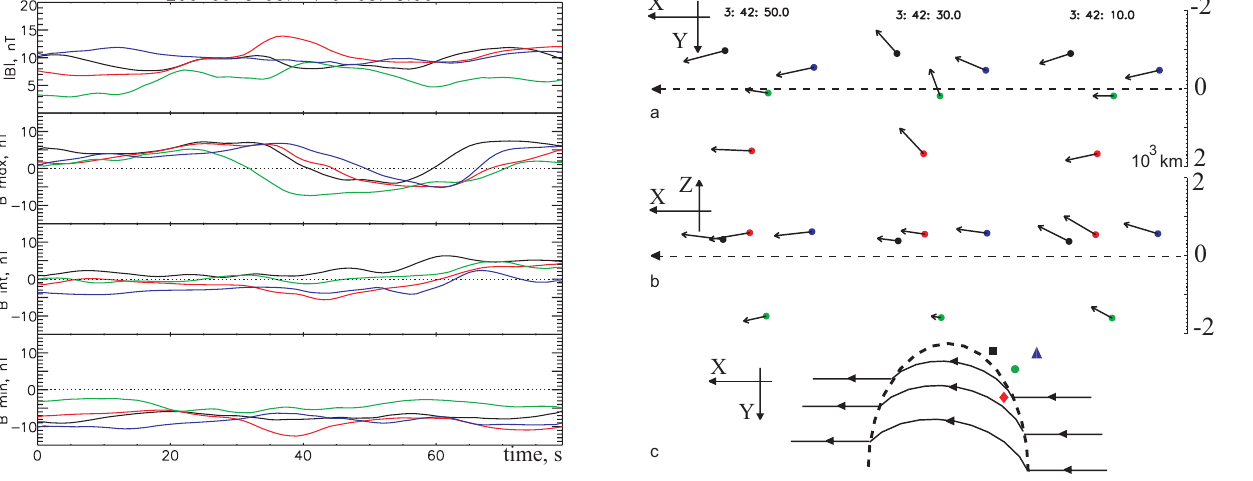
Fig. 7. Interval A 1: Projections of the magnetic field at the four s/c (black arrows) onto the XY (a) and XZ (b) GSM planes at three successive instances. The 3-D interpretation cartoon (c) shows a view to the equatorial plane from above. The dashed arrow indicates the spacecraft barycenter motion relative to the magnetic structure. Thick dashed line denotes the boundary of the magnetic structure. The solid lines represent the magnetic field force